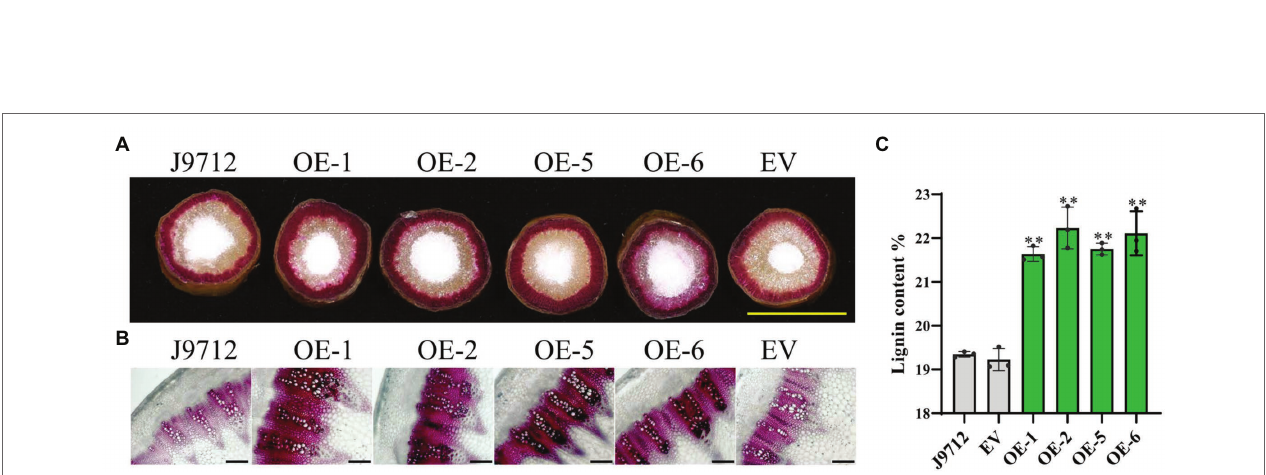
FIGURE 5 | Detection of lignin accumulation in the BnaC.CCR2.b overexpression lines. (A) Phloroglucinol-HCl staining of lignin in whole cross-sections. The scale bars represent 1 cm. (B) Phloroglucinol-HCl staining of lignin in manually obtained cross-sections. The scale bars represent 100 μ m. J9712, transgenic receptor line. EV, empty vector transgenic line. OE-1/2/5/6, BnaC.CCR2.b overexpression lines (T 2 generation). (C) Percentage of lignin content in stems of BnaC.CCR2.b overexpression lines, J9712 lines, and EV lines. The values are presented as the means ± SDs of three biologically independent replicates. The asterisks indicate significant differences between the overexpression transgenic lines and the J9712 lines ( * p < 0.05; ** p < 0.01; and Student’s